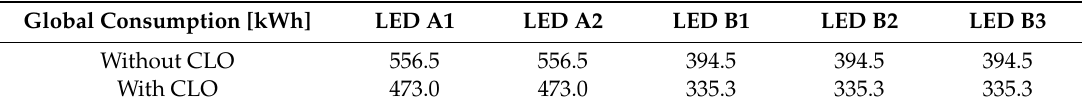
Table 4. Global power consumption with and without CLO.